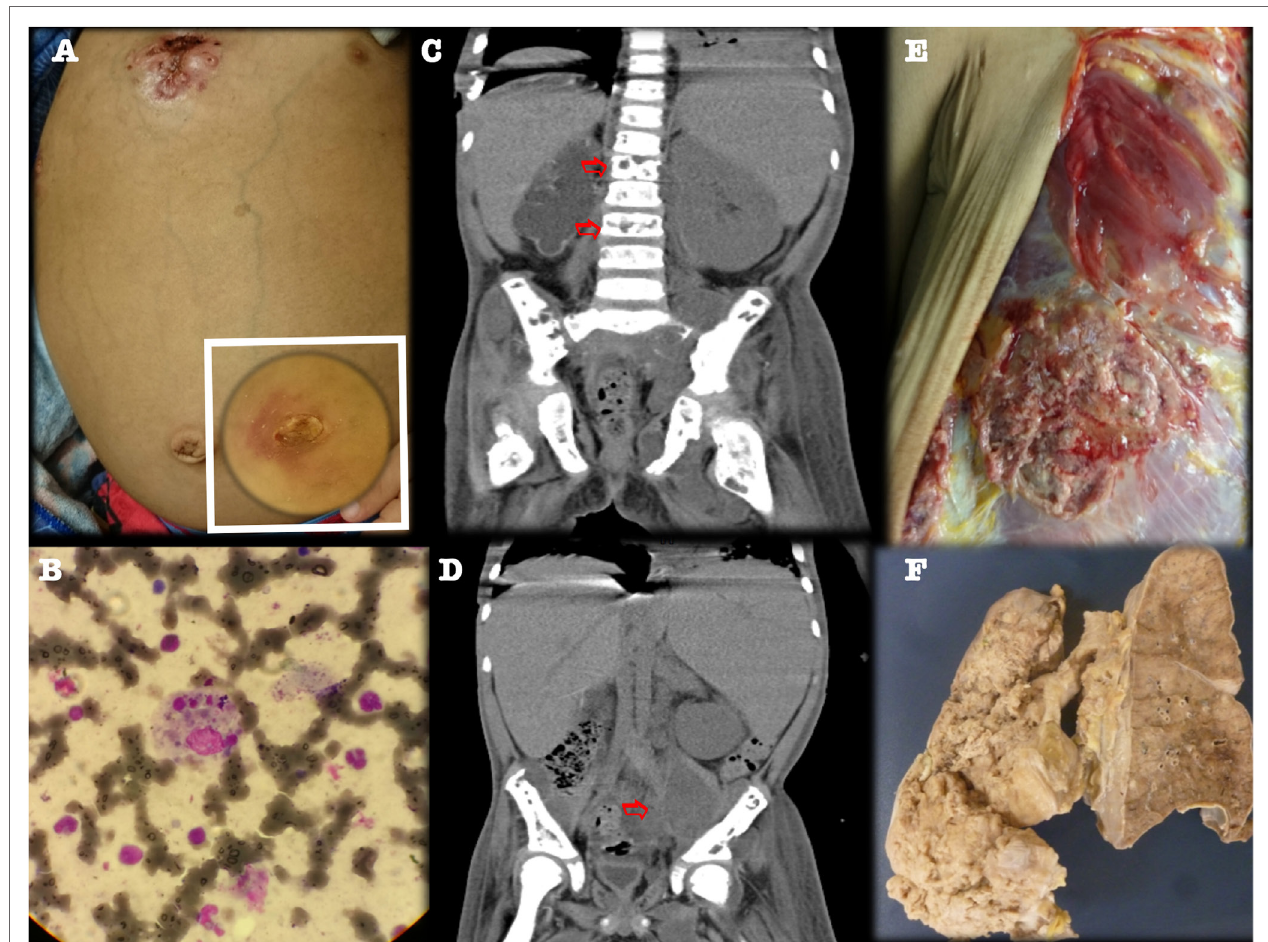
FIGURe 4 | third relapse with Ct scans showing left psoas abscess and multiple osteolytic lesions . (a) Fistulized multifocal pneumonia and left psoas abscess. (B) Bone marrow aspirate (Hematoxylin and eosin staining, 40 × ) showed histiocytes phagocytizing three blood cell lineages. (C,D) CT scan, coronal view, showing lumbar vertebral osteolytic lesions (panel C, arrows) and left psoas abscess (panel D, arrow). (e,F) Gross appearance of chest wall and lung specimen at autopsy, confirming multifocal fistulized pneumonia.